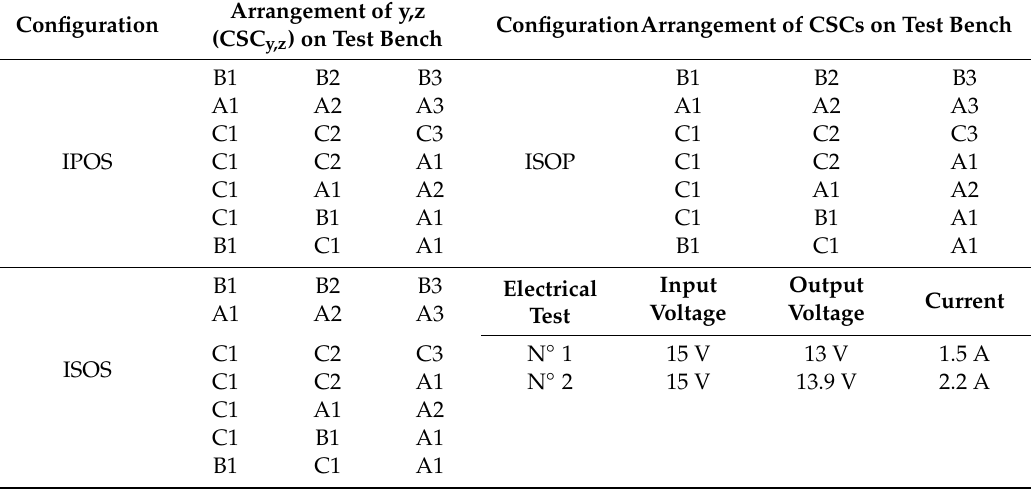
Table 5. Design of experiment with 3 × 3 CSC